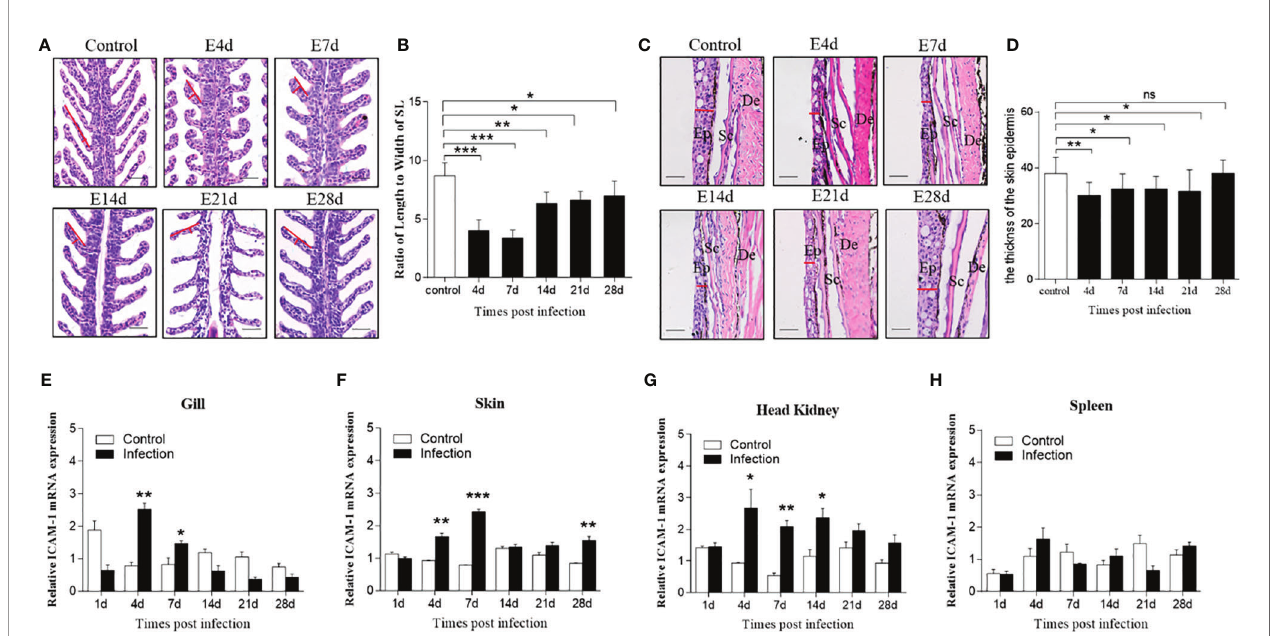
FIGURE 4 | Morphological changes of skin and gills and the expression level of ICAM-1 mRNA responses to IHNV in different tissues. (A) Hematoxylin and eosin (HE) stains of gills from mock-infected fi sh, and 4, 7, 14, 21, and 28 d after IHNV challenge, respectively. Red line indicates length or width of the secondary lamellae of (SL) gills. Scale bar, 40 m m. (B) The length-width ratio of gill SL from control and infected fi sh (n=6 per group). (C) Histological examination by HE staining of skin from trout infected with IHNV after 4, 7, 14, 21, and 28 days and uninfected fi sh. Red line represents the thickness of the skin epidermis. Ep, epidermis; Sc, Scales; De, dermis. Scale bar, 40 m m. (D) The statistics of the skin epidermis thickness including uninfected and infected fi sh (n=6 per group). (E – H) Fold change of ICAM-1 mRNA expression in gills (E) , skin (F) , head kidney (G) , and spleen (H) at 1, 4, 7, 14, 21, and 28 d post infection compared to control group (n=6 per group). Statistical analysis was performed by unpaired Student ’ s t test. ns P > 0.05, *P < 0.05, **P < 0.01, ***P < 0.001 . Data are representative of at least three independent experiments (mean ±